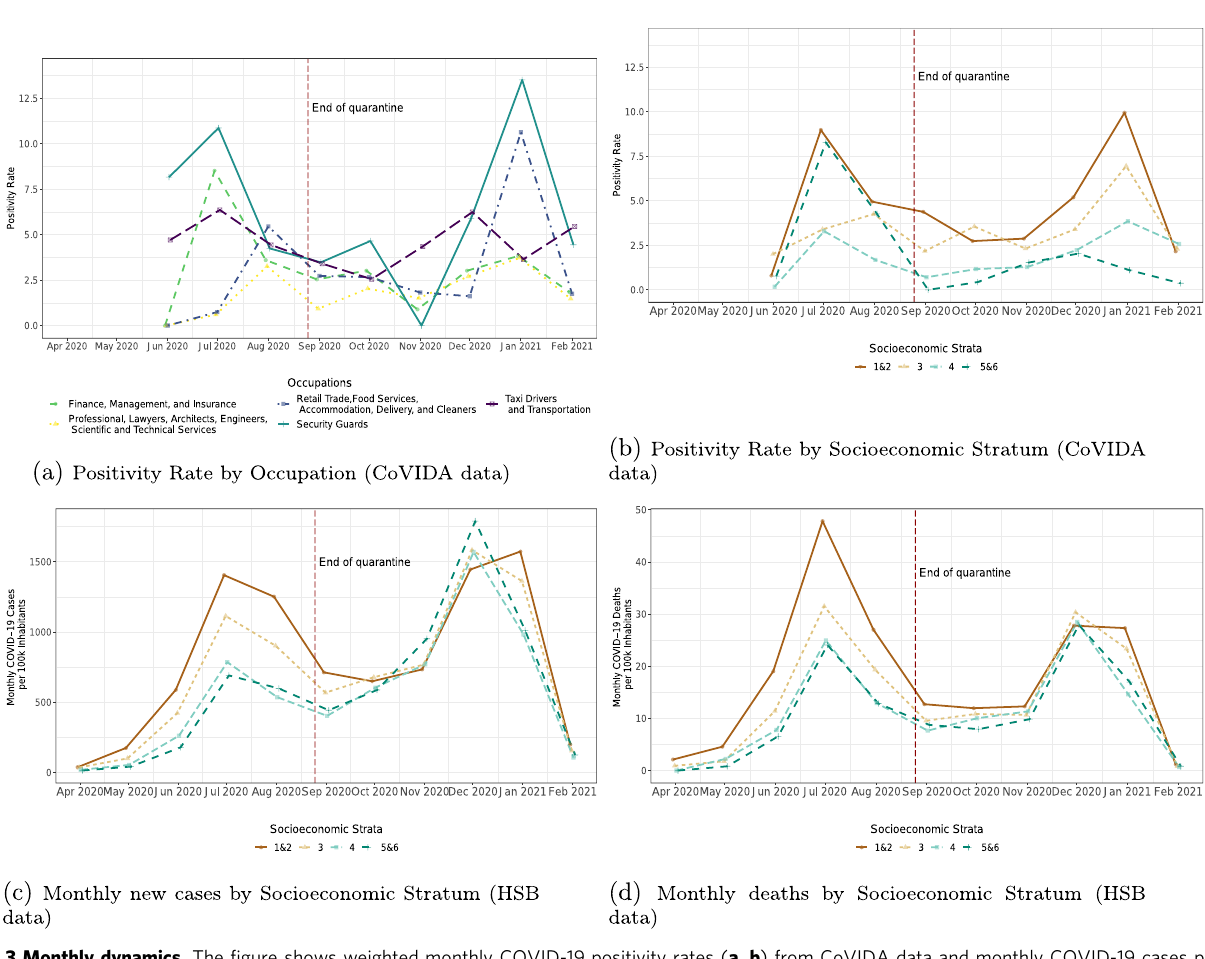
Fig. 3 Monthly dynamics. The fi gure shows weighted monthly COVID-19 positivity rates ( a , b ) from CoVIDA data and monthly COVID-19 cases per 100,000 inhabitants ( c , d ) from the Health Secretary of Bogota (HSB). The vertical dashed line marks the end of quarantine on August 25, 2020. Weights are based on workers' occupation to be representative of Bogota ’ s population. To maintain comparability, ( d ) uses the date of the positive test of deceased individuals on the horizontal axis. See Supplementary Fig. 7 for 95% con fi dence